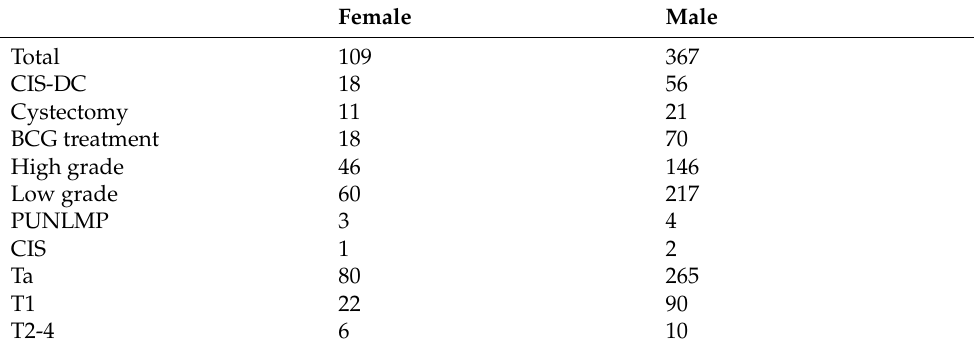
Table A1. Dataset characteristics per sex (female/male). BCG—Bacillus Calmette–Guérin vaccine.